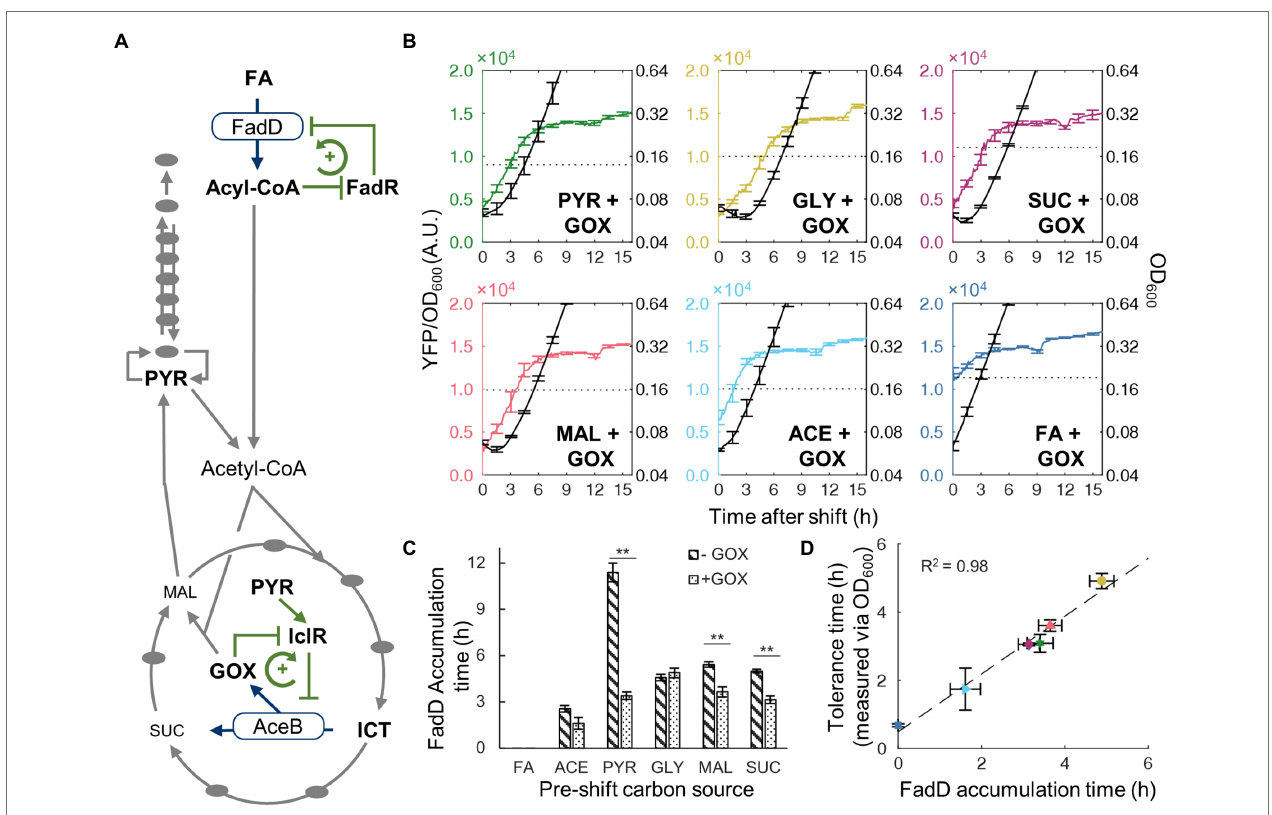
FIGURE 4 | Activity of glyoxylate shunt affects tolerance time. (A) Simplified metabolic network with key positive feedback regulatory interactions for FA utilization. Metabolic enzymes (FadD/AceB) convert a precursor into a regulatory metabolite intermediate (acyl-CoA/glyoxylate). The regulatory intermediate represses the activity of a transcription factor (FadR/IclR) which alleviates the repression of the metabolic enzyme. IclR activity is also activated by pyruvate. (B) Time course of YFP/OD 600 from FadD-YFP fusion (colored line, left axis) and OD 600 (black line, right axis) after shifts from a glyoxylate supplemented gluconeogenic carbon source to FA (not supplemented with glyoxylate). Error bars represent SEM with n = 3 for FA, ACE, MAL, and SUC, n = 4 for PYR, and n = 5 for GLY. The dotted line indicates the YFP/OD 600 level when cells resume steady state growth. (C) FadD accumulation time for nutrient shifts from carbon source without glyoxylate (stripes) or with glyoxylate (dotted). Stars indicate significant change in accumulation time, two-tailed t -test (**, p < 0.01). (D) Correlation between tolerance time and FadD accumulation time for shifts from carbon with glyoxylate to FA. Tolerance timed determined by time course optical density measurements ( Supplementary Figure S4 .) Dashed line is a least-squares linear